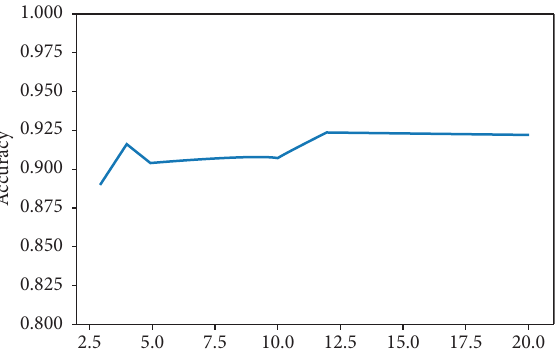
Figure 6: Te average accuracy curve for feature vector f